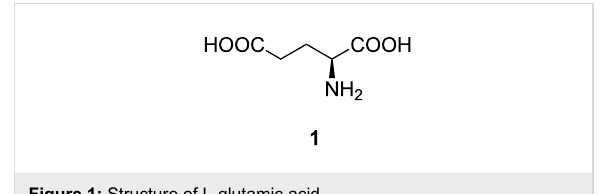
Figure 1: Structure of L-glutamic